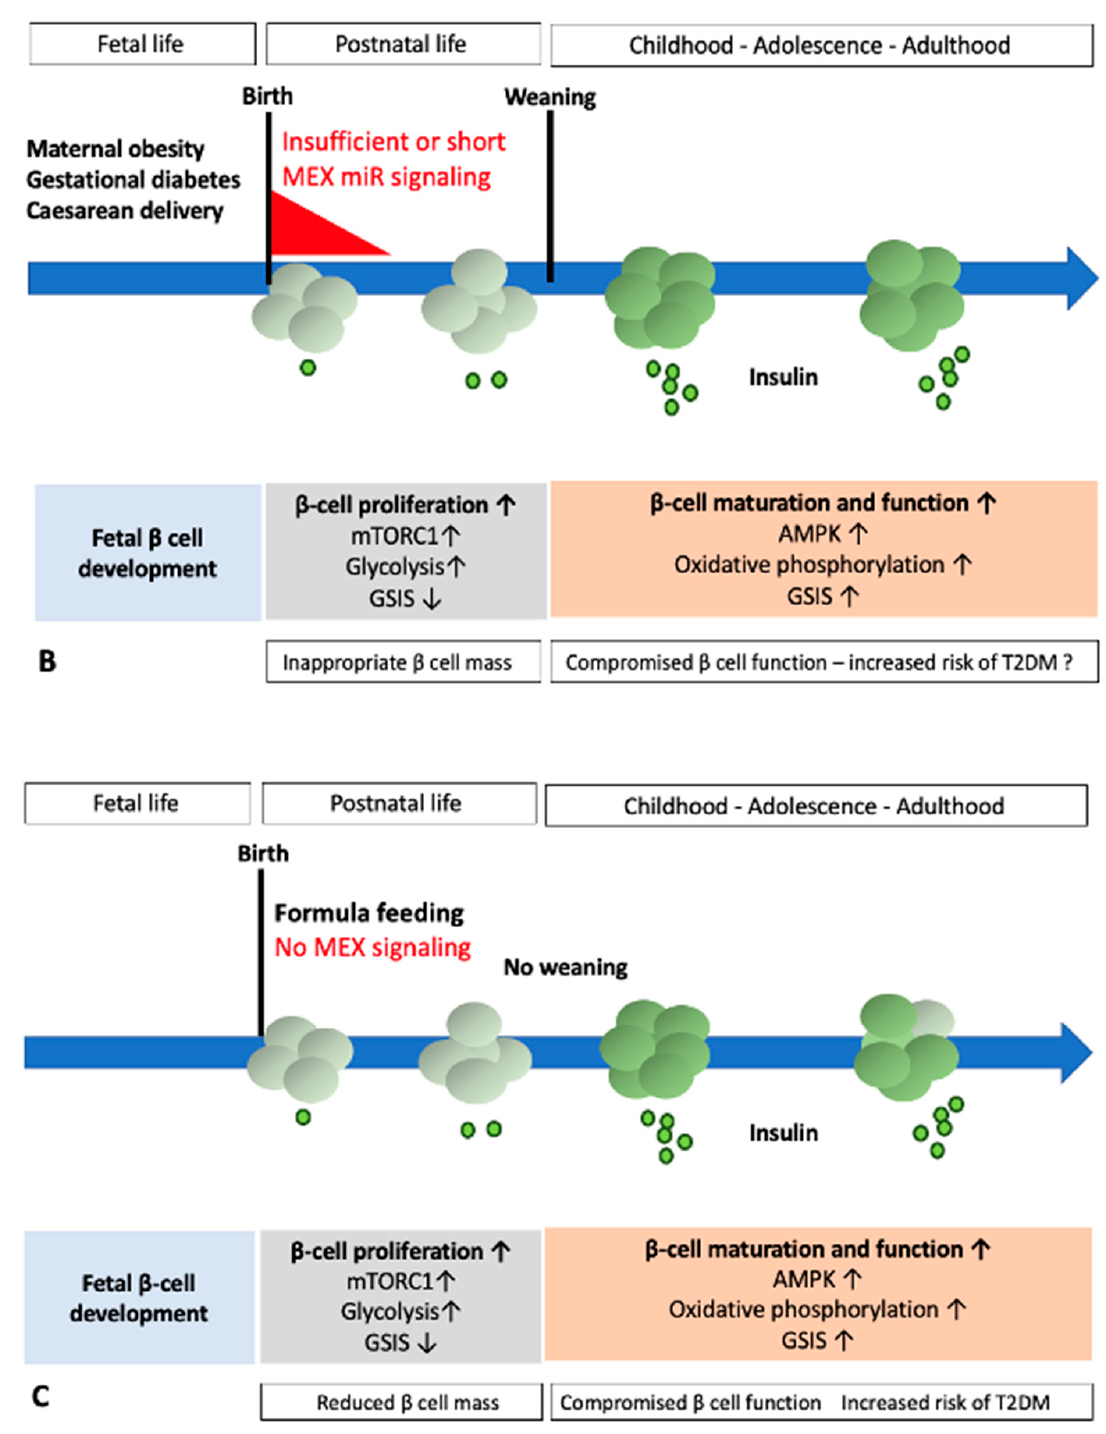
Figure 9. Selected constellation of milk exosome (MEX) miR signaling during the postnatal period. ( A ) Physiological breastfeeding promoting adequate β cell mass expansion. No further bovine MEX exposure after the lactation period. ( B ) Insufficient or disturbed postnatal MEX signaling due to maternal obesity, gestational diabetes, or caesarean delivery, compromising β cell mass expansion. No further bovine MEX exposure during adult life. ( C ) Artificial postnatal formula feeding without MEX signaling and no further MEX availability during adult life. One arrow up = upregualtion; two arrows up = extensive upregulation; one arrow down =